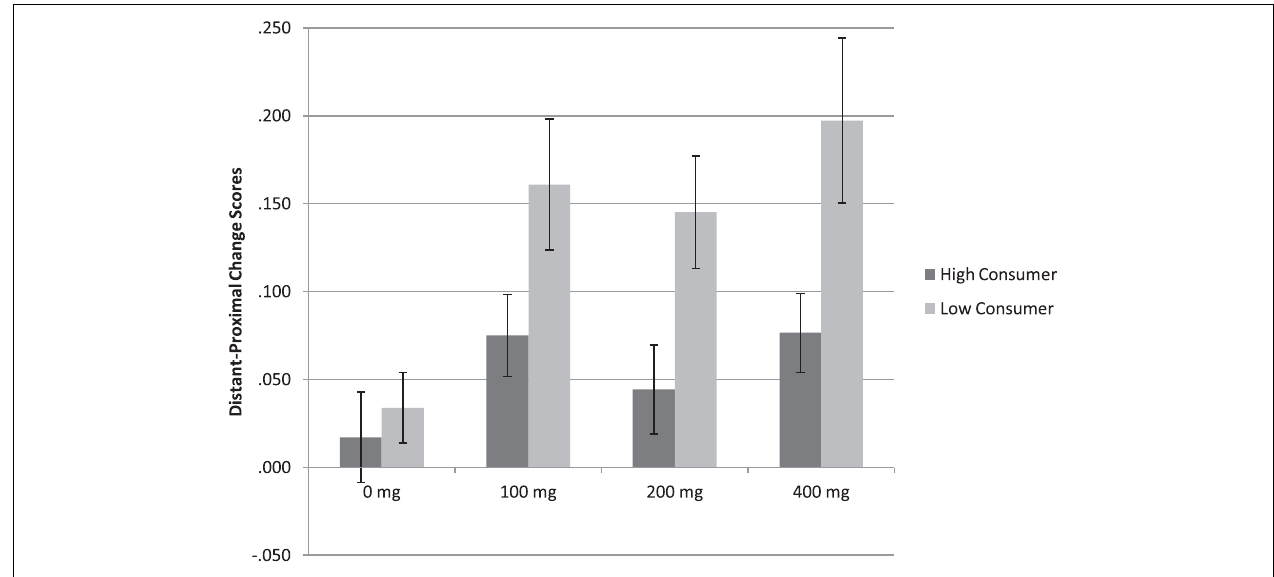
between distant and proximal distances was higher after all doses caffeine intake than placebo ( p <0.001) and higher in low relative to high habitual caffeine consumers ( p